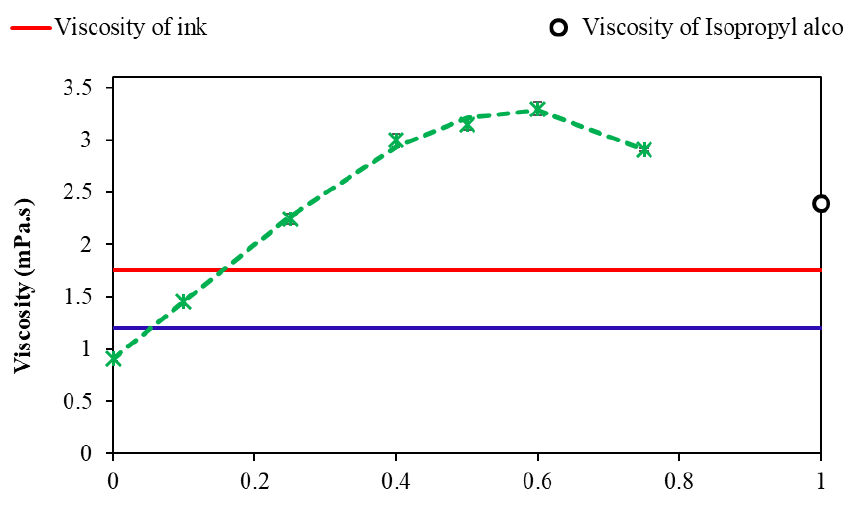
Figure 7. Dynamic viscosity tests of isopropanol/deionised water-fractions, inkjet commercial ink and ethanol. The white band (bounded by the horizontal blue and red lines) on the graph indicates the dynamic viscosity range limit for successful printing.